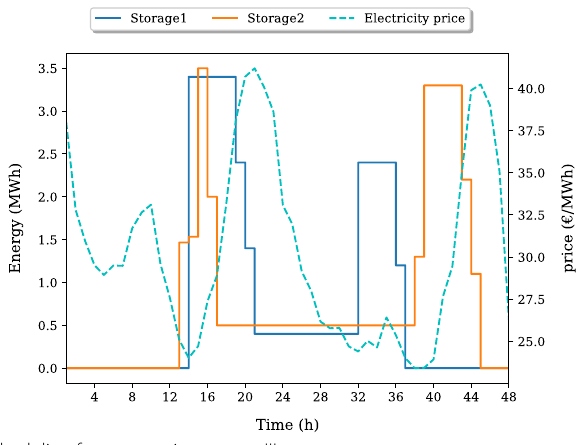
Fig. 8 Optimal scheduling for storages in use case